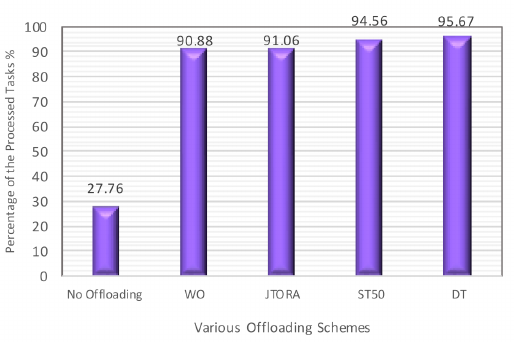
Figure 6. The Comparison of the Throughputs with Various Offloading